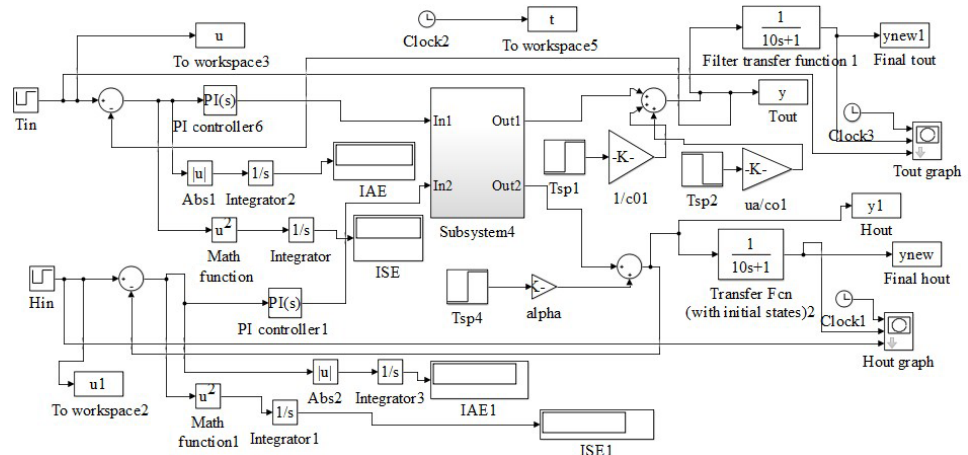
Figure 9. MATLAB/SIMULINK Diagram of Closed-Loop Greenhouse Model with PI Controller.